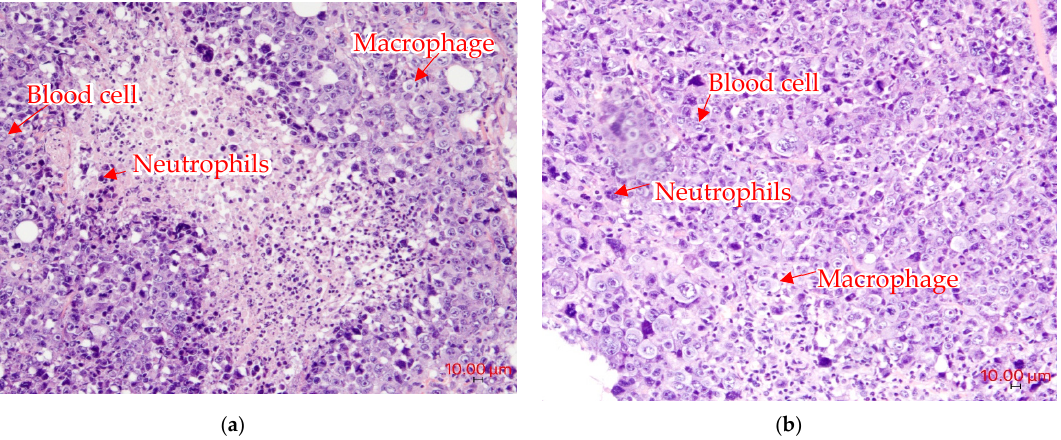
Figure 5. Histopathological demonstration of significant tumor necrosis (Ehrlich-carcinoma. Group II mouse) following EcPHL treatment. Necrotic areas show intermixing of dead and dying tumor cells and inflammation. ( a )—(H&E stain, magnification ×100); ( b )—(H&E stain, magnification ×200).